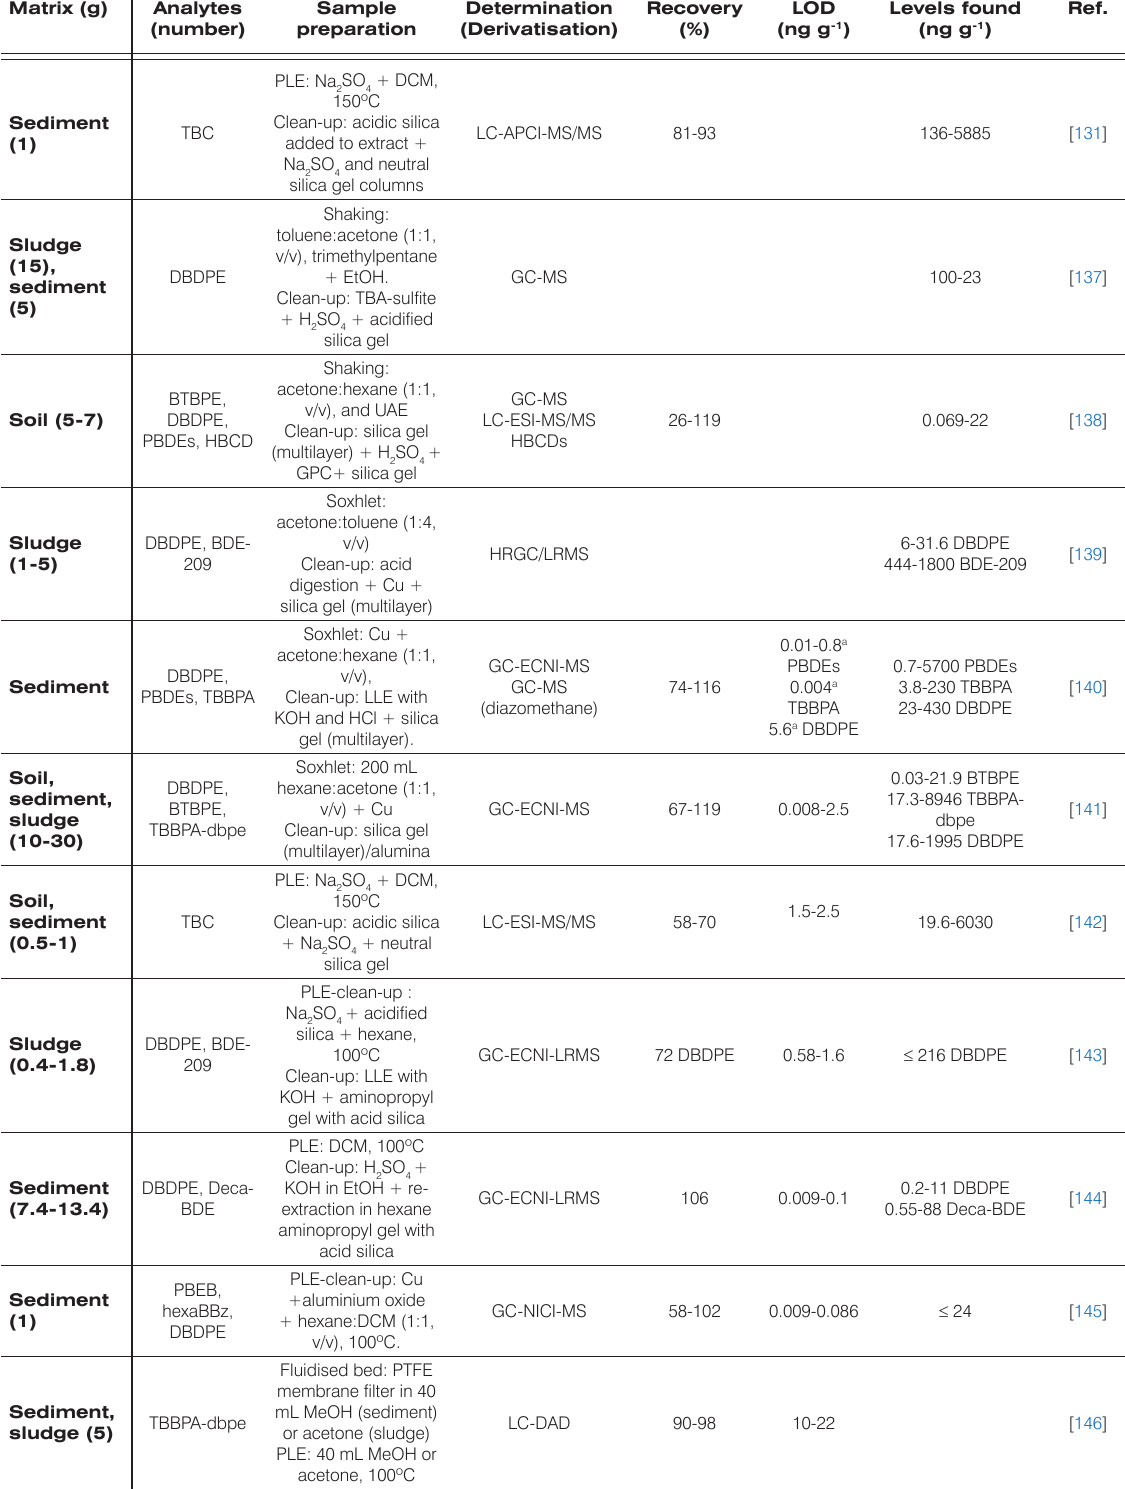
Table 5. Analysis of NBFRs in environmental solid